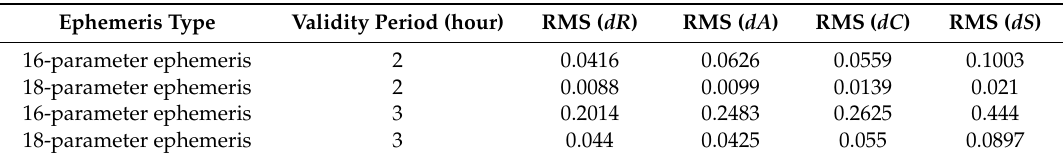
Figure 5. The prediction errors in 15 min after the 3 h validity period by the 18-parameter ephemeris and the 16-parameter ephemeris (18EphPredict and 16EphPredict) for satellite 3 starting from UTC 2017 / 07 / 05 00:00:00. Table 2. The RMS of prediction errors in 15 min by the 18-parameter ephemeris and 16-parameter ephemeris from all GPS satellites over two